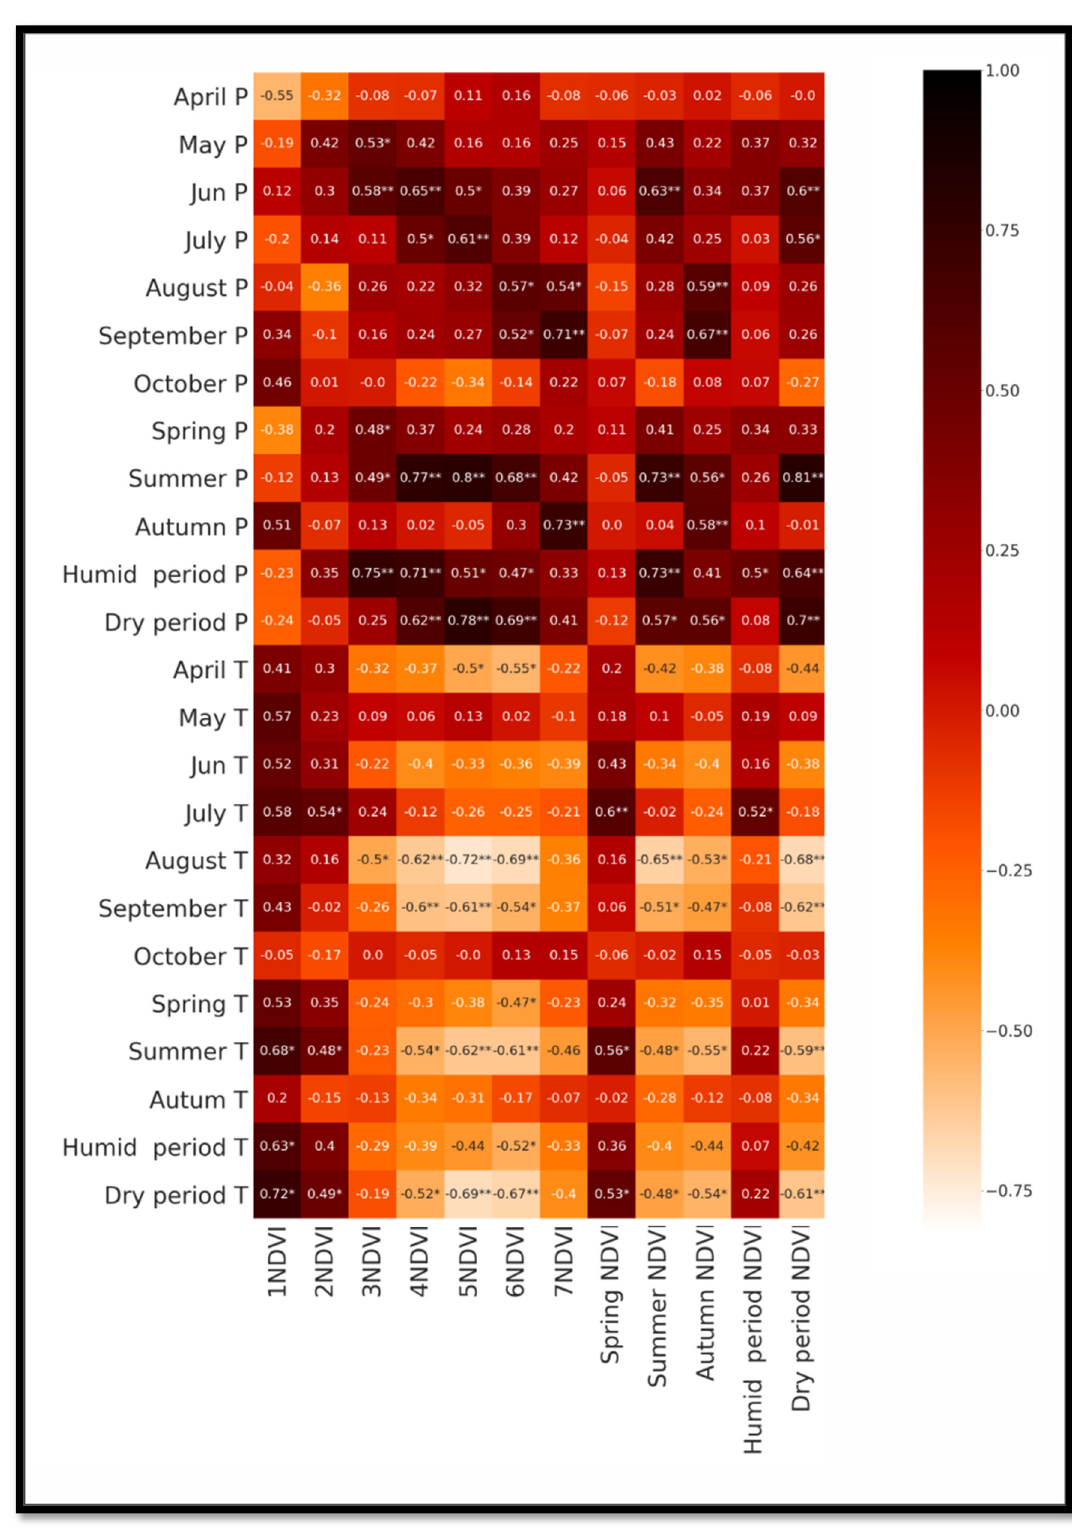
Figure 8. Correlation between temperature, precipitation, and the average monthly, seasonal MODIS NDVI data (with BRDF and topographic, atmospheric correction) for Sisian for the 2000–2018 period, with the levels of significance: *— p < 0.05, ** p <